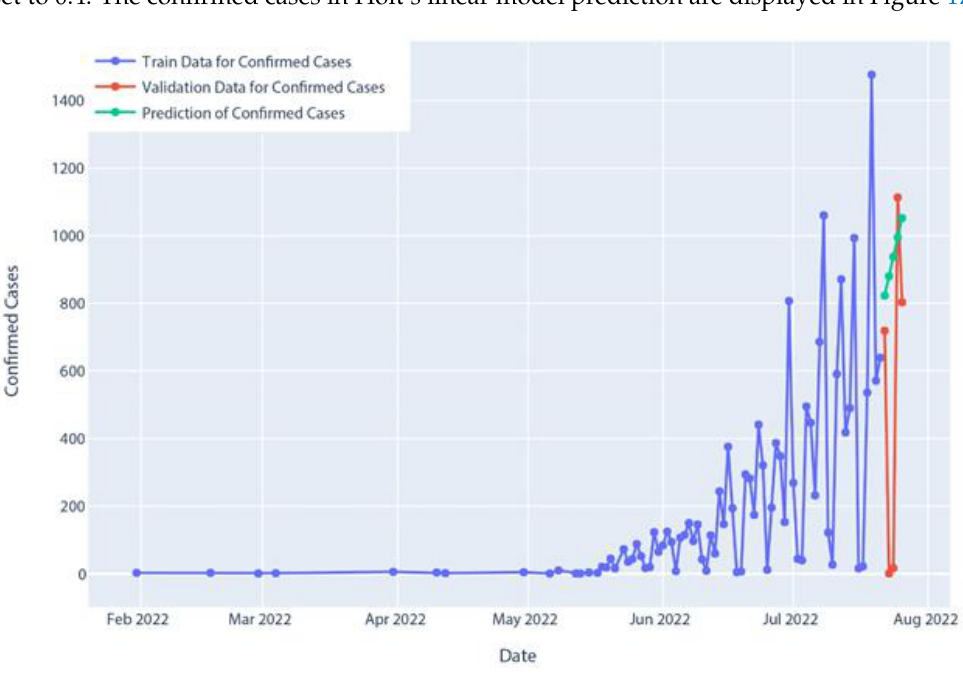
Figure 17. Confirmed cases in Holt’s linear model prediction.